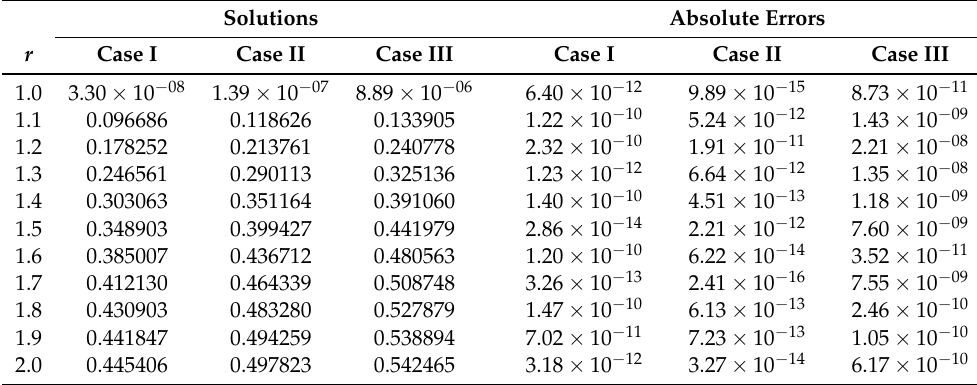
Table 6. Approximate solutions and Absolute errors obtained by the LNN-GNDO-SQP algorithm for SCENARIO IV of the drainage problem.